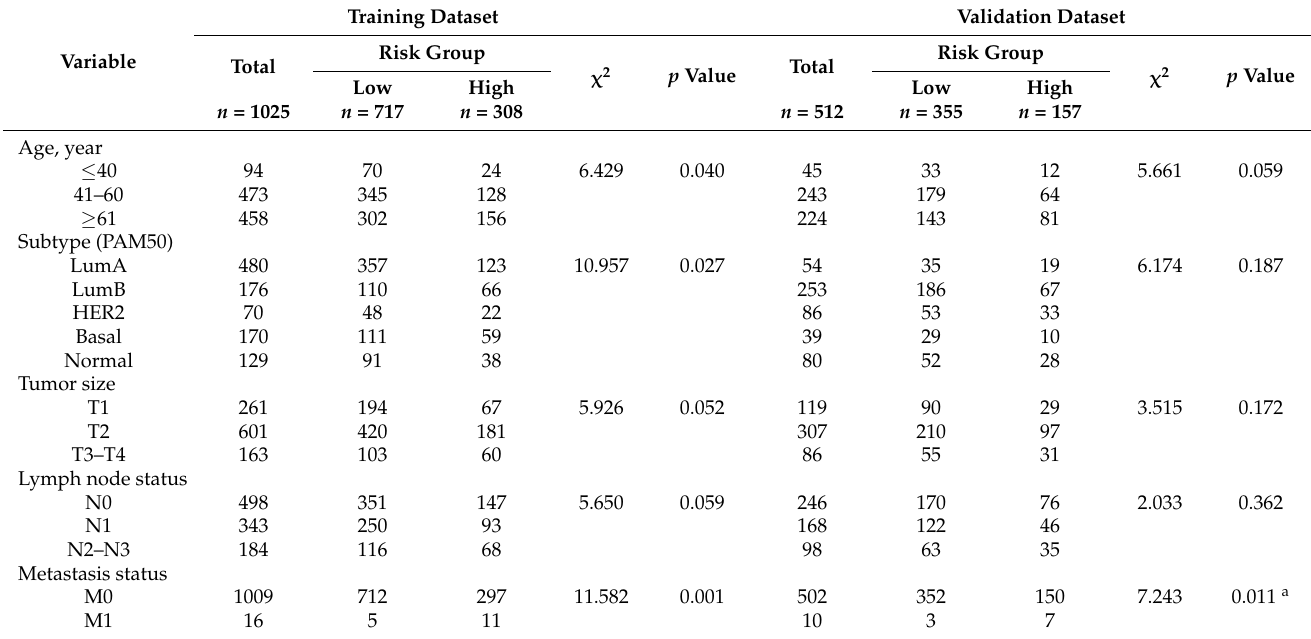
Table 1. Demographic and Clinical, Pathologic Characteristics of Patients with Breast